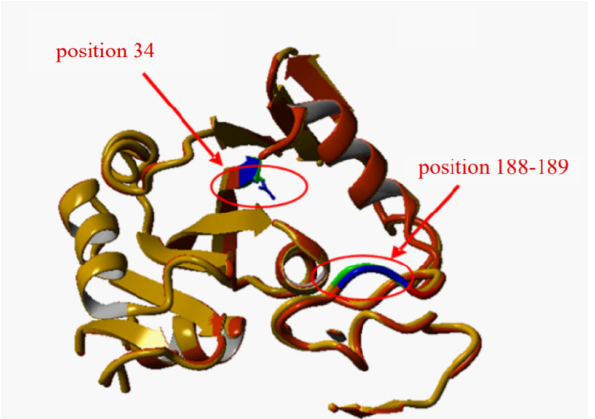
Figure 5. The mutual orientation of sites 34 and 188–189 in the N-terminal domain (fragment of 1 to 200 amino acid residues). In red—wild type D34; in yellow—mutant protein G188TP189K. 200 amino acid residues). In red—wild type D34; in yellow—mutant protein